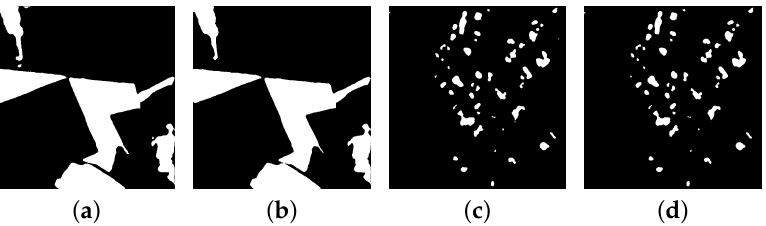
Figure 16. Ablation study of multimodal conditional random field on the SZTAKI dataset. ( a ) MSAK- Net of Tiszadob, ( b ) MSAK-Net-MCRF of Tiszadob, ( c ) MSAK-Net of Szada, ( d ) MSAK-Net-MCRF of Szada. Table 3. Ablation study of multimodal conditional random field on OSCD and SZTAKI datasets. Test